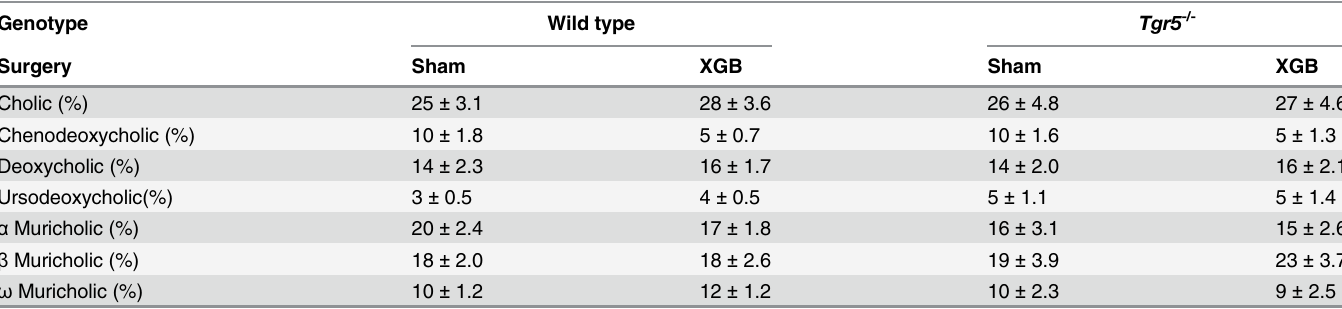
Values correspond to the mean ± SE of 5 – 7 wild type mice and 3 – 4 Tgr5 -/- mice. Concentration of serum lithocholic acid was < 1% ( < 0.05 μ M) in all groups of animals. XGB, cholecystectomy.